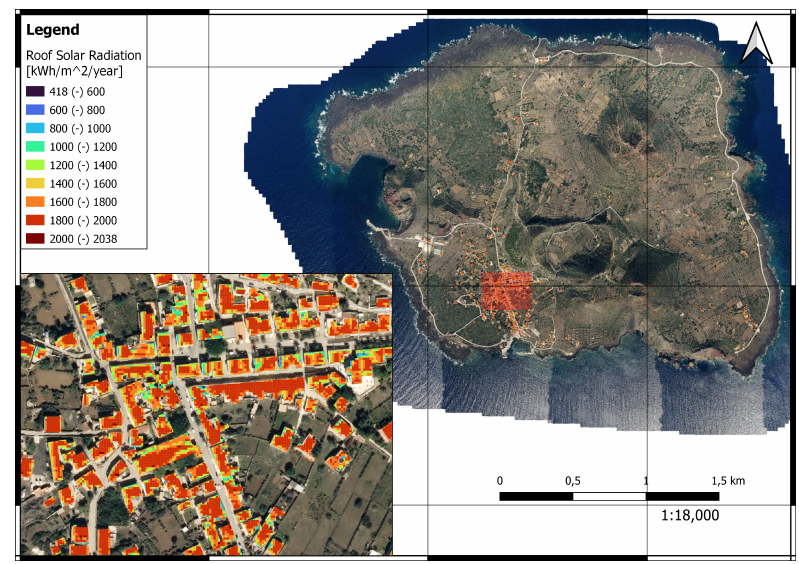
Figure 21. Solar radiation on Linosa roofs.